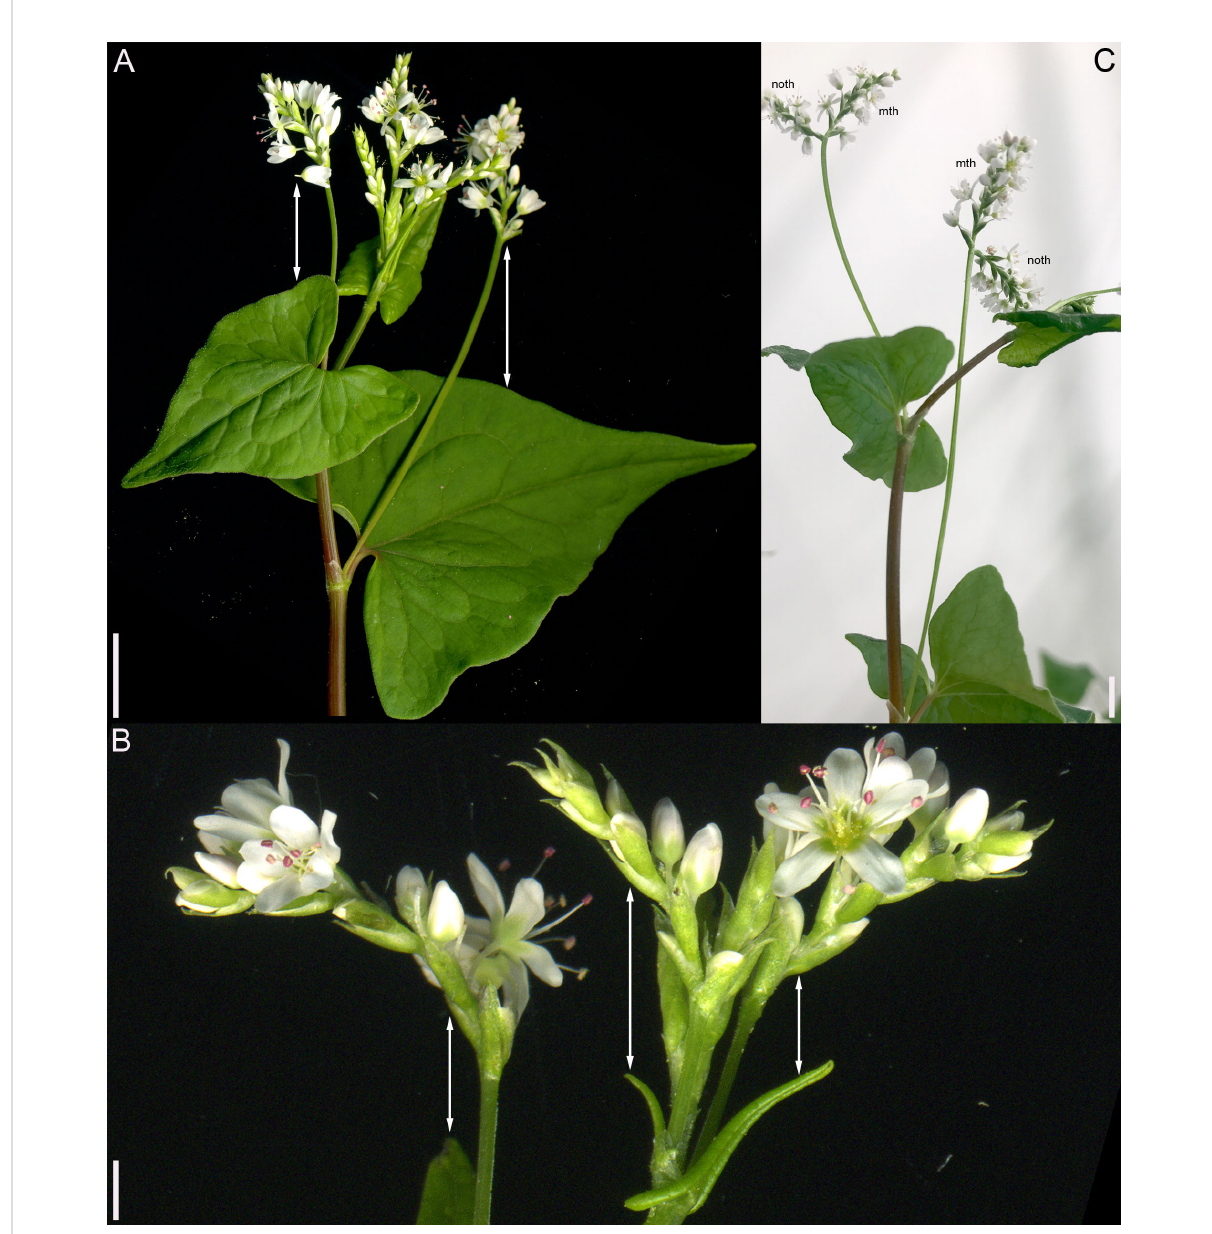
FIGURE 9 In fl orescence morphology in Fagopyrum esculentum subsp. ancestrale . (A, B) Upper part of in fl orescence of typical morphology (see Figure 5C, for diagram). (B) Detail of in fl orescence tip similar to that in (A) showing young lateral thyrses. Arrows in (A, B) show leaves subtending particular thyrses. (C) Unusual specimen with ‘ double thyrses ’ resembling those observed in F tataricum K17 and F cymosum. mth, main thyrse of a pair; noth, next order thyrse of a pair. Scale bars = 1 cm (A, C) , 2 mm (B)